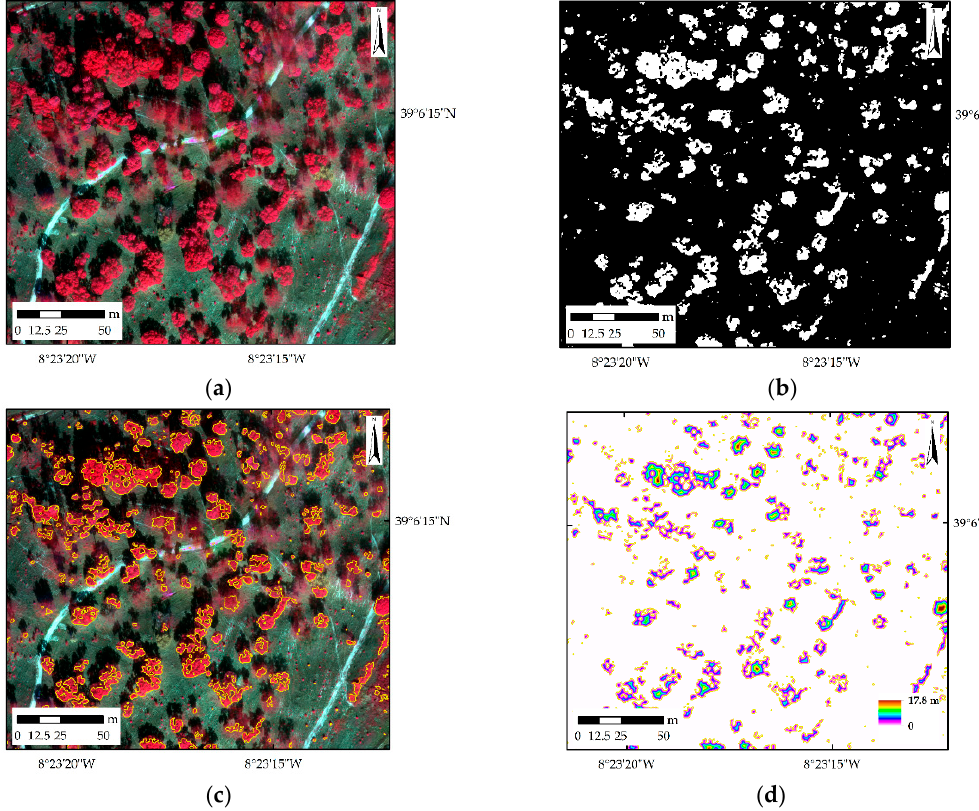
Figure 4. HMG test site: ( a ) False-colour composite image (NIR, R, G); ( b ) Binary image with the tree crowns (in white); ( c ) tree crown´s delimitation (in yellow) superimposed on the false-colour composite; and ( d ) Euclidean distance calculated from the binary image.